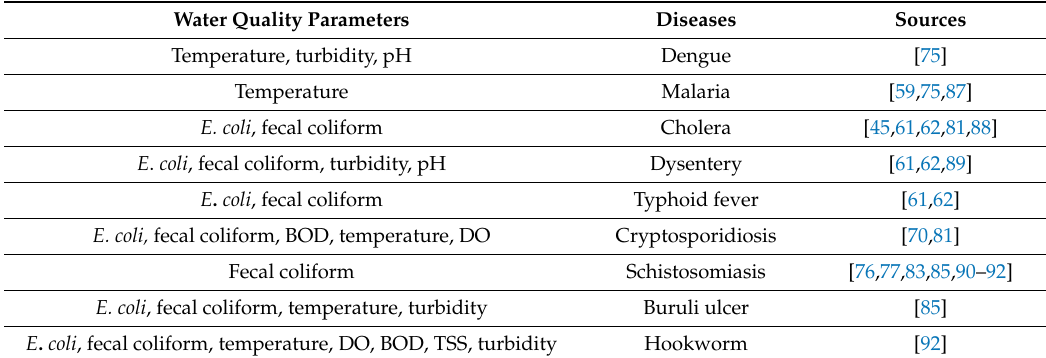
Table 3. Summary of water quality parameters and the potential infectious diseases.